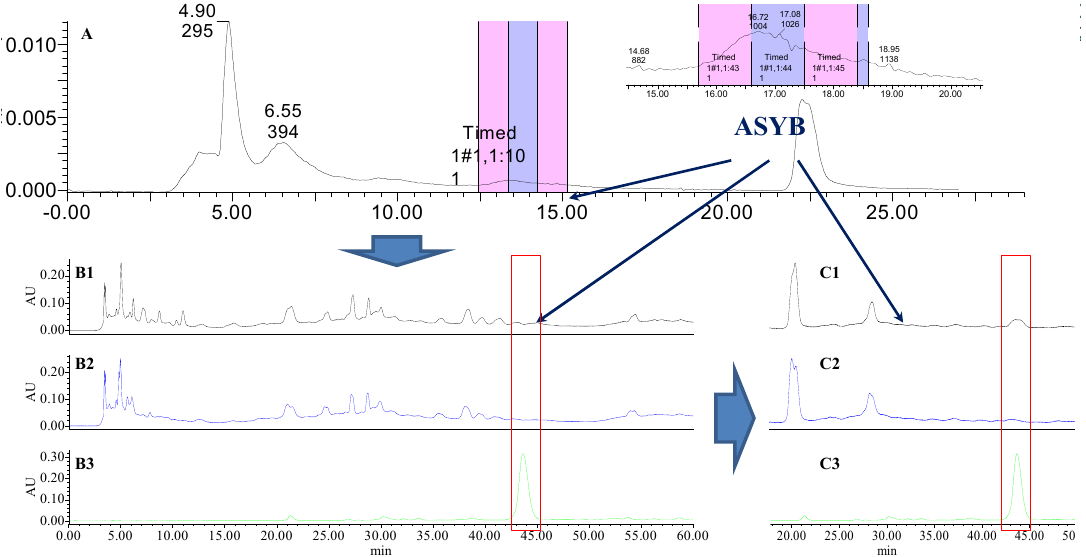
Figure 10. The preparative and analytical chromatograms of the depletion of ASYB from CF. ( A ) preparative chromatogram at 270 nm; ( B1 ) analytical chromatogram of CF at 270 nm; ( B2 ) analytical chromatogram of CF-B at 270 nm; ( B3 ) analytical chromatogram of ASYB depleted from CF at 270 nm. ( C1 ) analytical chromatogram of CF at 400 nm; ( C2 ) analytical chromatogram of CF-B at 400 nm; ( C3 ) analytical chromatogram of ASYB depleted from CF at 400 nm.